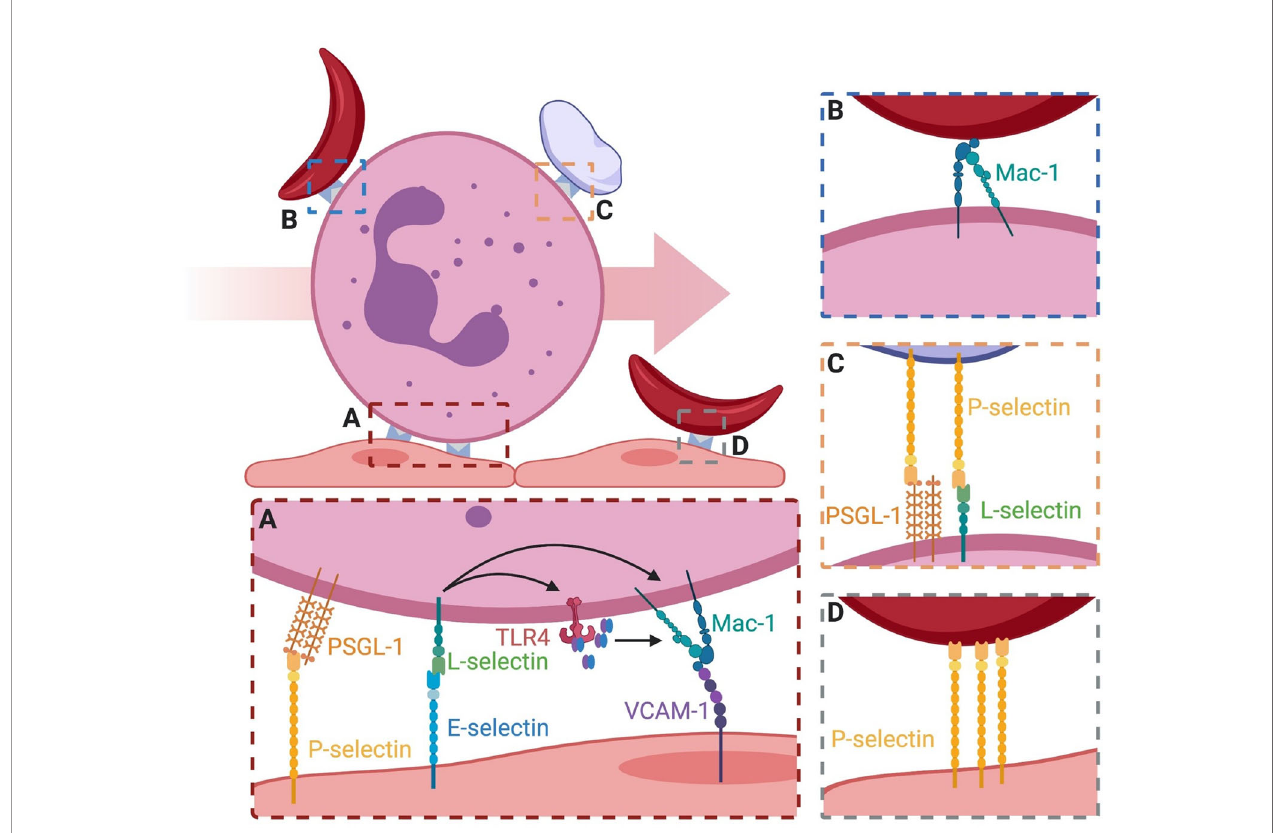
FIGURE 2 | Binding events that lead to vasculature occlusion on in fl amed endothelium. (A) Neutrophil rolling is mediated by P-selectin and E-selectin binding PSGL- 1 and L-selectin. Signaling through E-selectin/L-selectin bonds results in (1) release of MRP8/14 and endogenous activation of surface TLR4 which primes integrin for activation and (2) direct signaling of transition to a high-af fi nity integrin state capable of binding ligand. High af fi nity integrin is capable of stable bond formation to VCAM-1 and ICAM-1 on endothelial to mediate neutrophil arrest. (B) Secondary capture of sRBC to adherent neutrophils is mediated via Mac-1. The mechanism of capture is an active area of research. (C) Secondary capture of platelets to adherent neutrophils is mediated through platelet surface P-selectin and its binding to PSGL-1 and L-selectin. (D) Direct engagement of sRBC to the surface of endothelial cells has been attributed to P-selectin, similar to secondary capture via